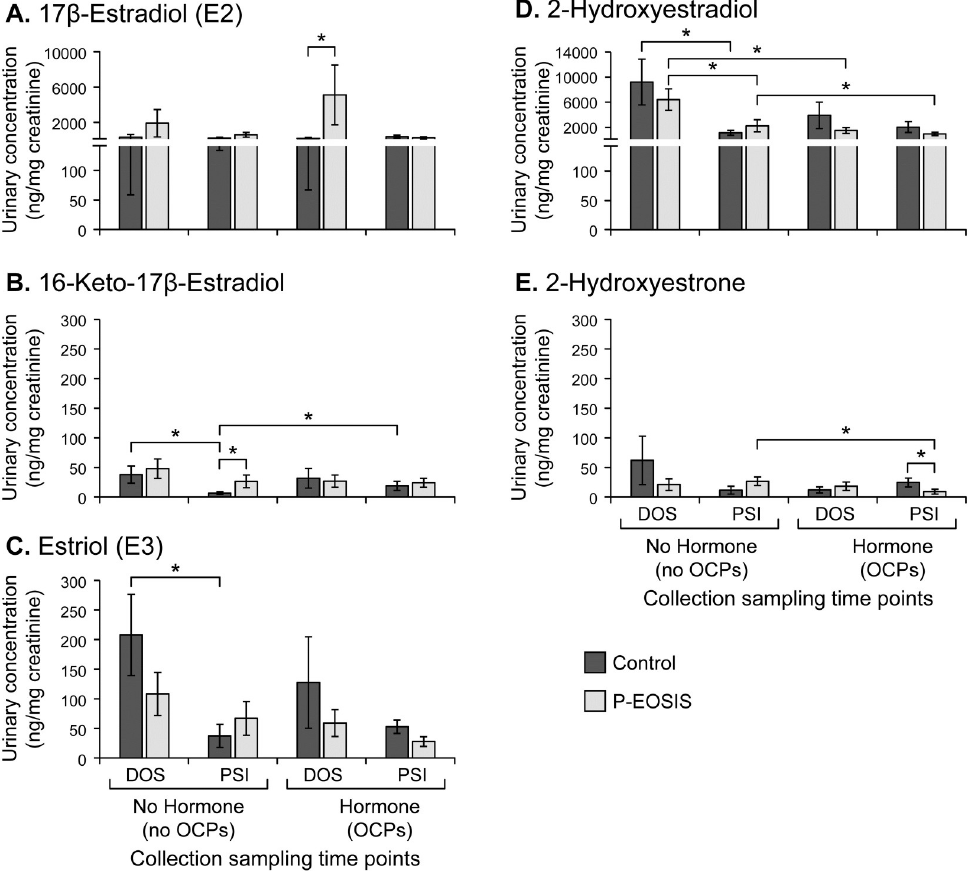
Fig 1. Urinary estrogen metabolites levels in control subjects (control) or patients with endometriosis (P-EOSIS). All subjects were either without hormonal therapy (left panel; control = 4; P-EOSIS = 10) or on hormonal therapy (right panel; control = 5; P-EOSIS = 10) at the time of surgery (DOS) and post-surgery intervention (PSI). Levels of estrogen metabolites were normalized to urinary creatinine. A . 17 β -estradiol. B . 16-Keto-17 β -Estradiol. C . Estriol. D . 2-Hydroxyestradiol. E . 2-Hydroxyestrone. � indicates significant difference between groups, Mann-Whitney test, P-value < 0 . 05 , error bars indicate SEM.